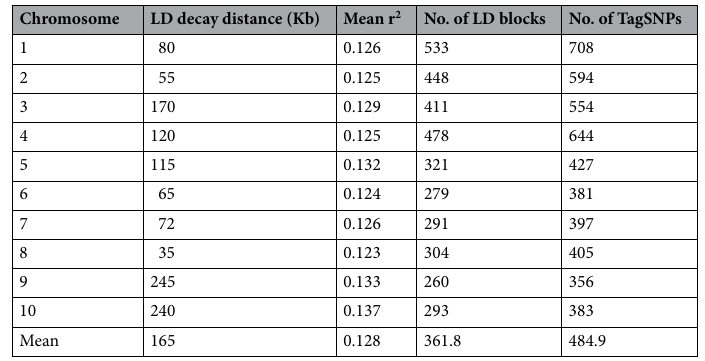
Table 1. The LD, LD decay distance, LD block, and TagSNPs.